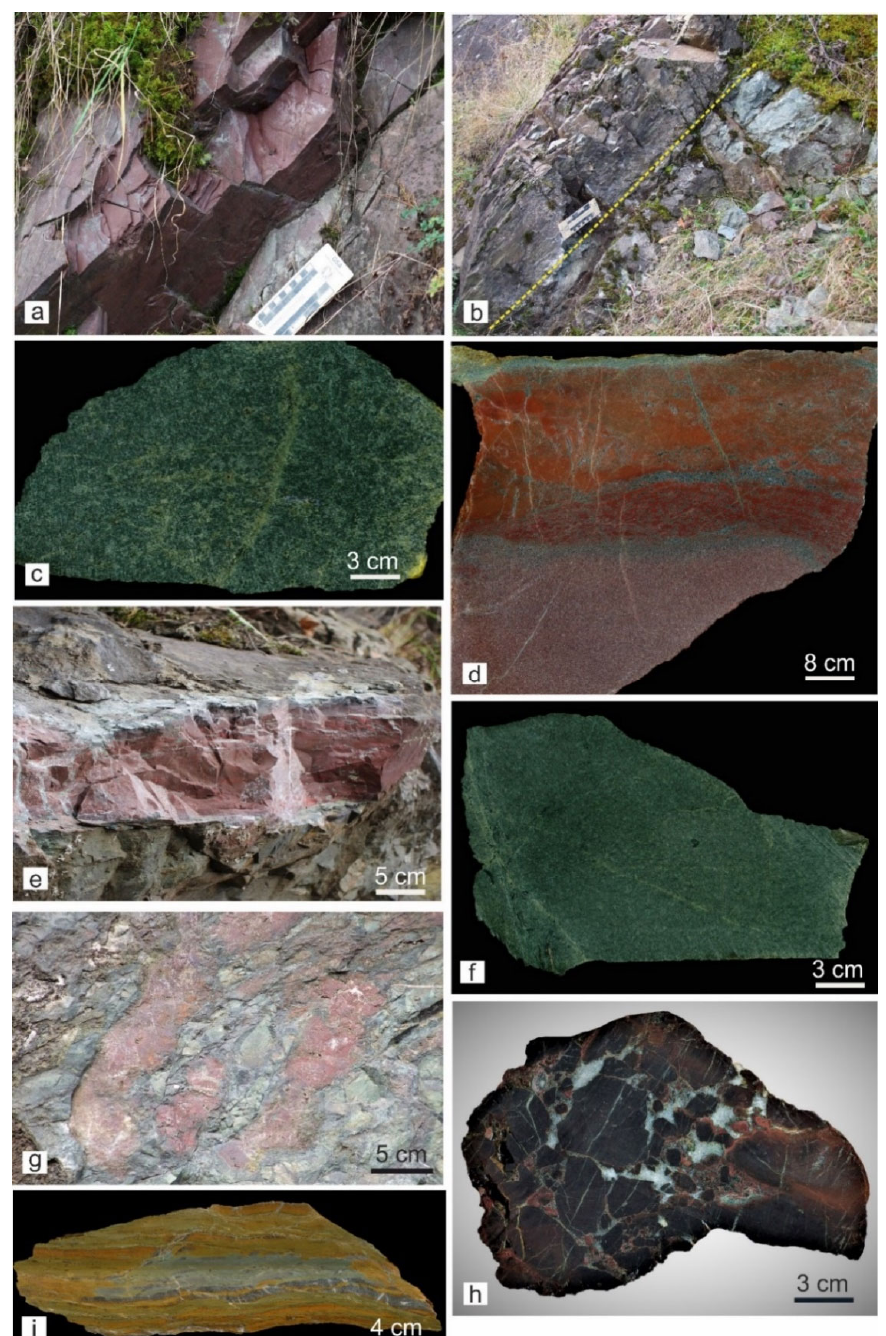
Figure 7. Rock lithology from the oceanic Jaklovce Succession. ( a ) Reddish cherty schists from the Lower Beds with Ladinian radiolarians (s. JAK ‐ 1/3). ( b ) Alternation of reddish and greenish cherty schists (s. JAK ‐ 1/2~JAK ‐ 5, 5A) to metaradiolarites with a half ‐ meter thick metabasalt layer (s. JAK ‐ 1, below dashed line) from the Middle Beds. ( c ) Detailed view on metabasalt s. JAK ‐ 1. ( d ) Reddish carbonate (bottom) passing upwards into the middle dark ‐ red cherty clayey ‐ carbonatic shale (s. JAK ‐ 2/1 with Middle to Upper Triassic radiolarians) and the top radiolarite with basaltic tuff layer. ( e ) Regular alternation of metabasalts ( f ) and metaradiolarite layers is often disturbed by ( g ) Peperitic breccias. ( h ) Brecciated margin of a lava flow with secondary Cal infilling cracks (s. JAK ‐ 5/19). (d)–(h) The Upper Beds. ( i ) Jurassic calciturbidites (calcareous flysch) with brownish carbonatic sandstone layers (s. JAK ‐ 202).